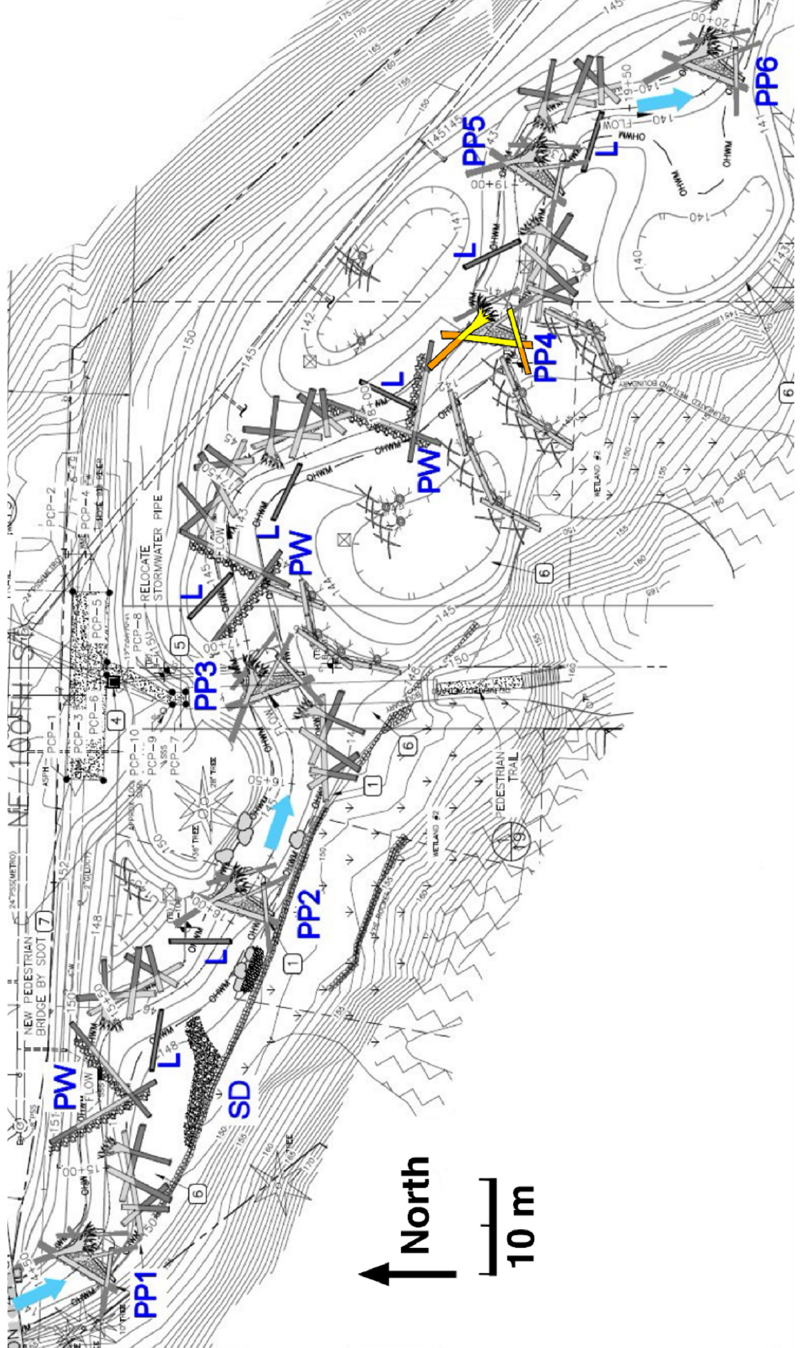
Figure 7. Plan view of the majority of the Kingfisher restoration project. Flow is from upper left to lower right, indicated by light blue arrows. Hyporheic enhancements include: PP 1–4 = plunge ‐ pool structures; SD = subsurface water drain; PW = pocket ‐ water logs; and, L = hyporheic log. Plunge ‐ pool No. 4 (PP4) is highlighted in yellow (above ground portion) and orange (portion buried in streambed); this structure was singled out for intensive study.